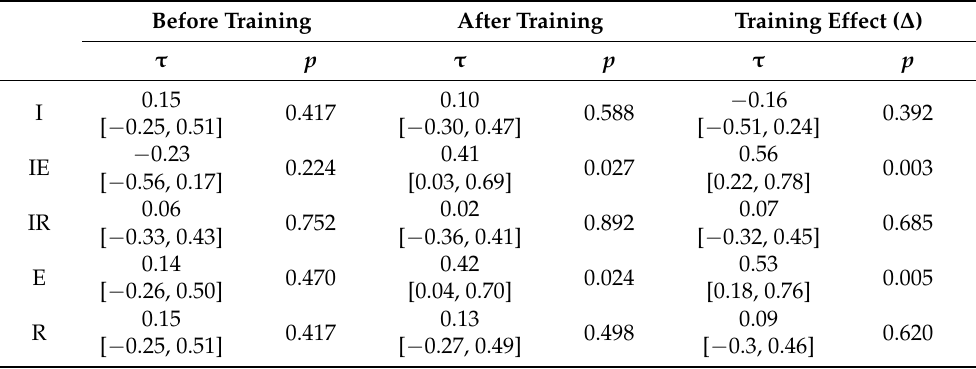
Table 3. Correlation between body fat percentage and cortisol concentrations (I, E, R) and reactions to exertion (IE, IR) for the states before training and after training and the changes in these values between both states, which resulted from